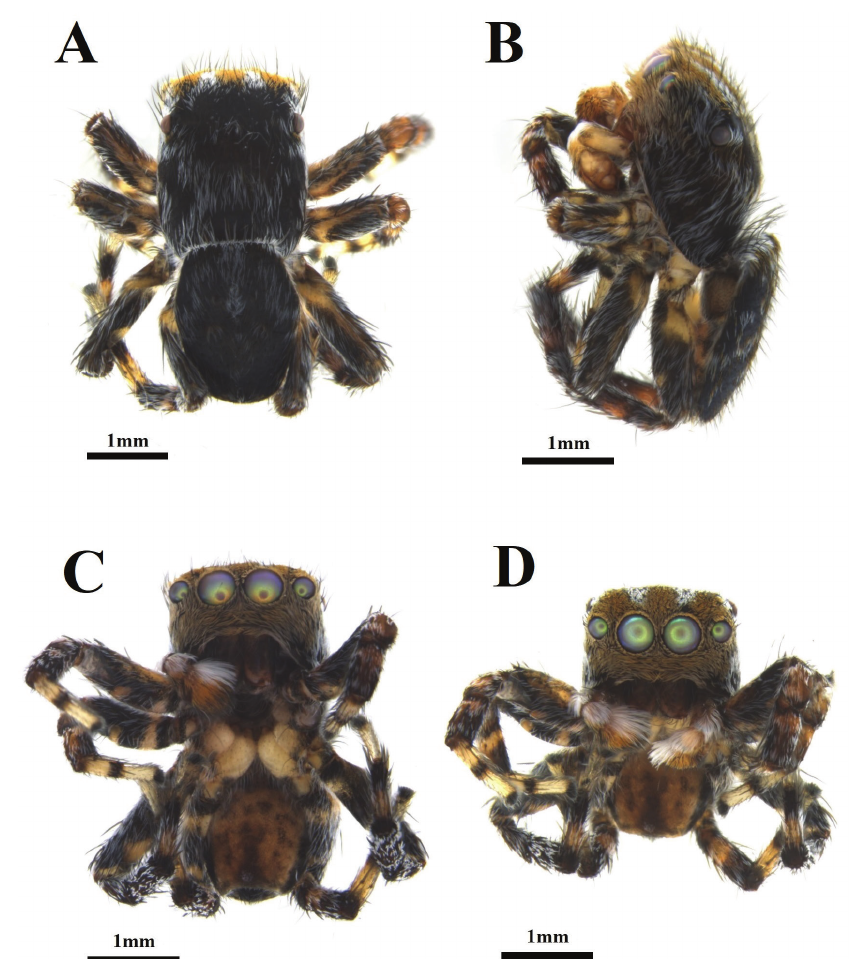
Figure 2. Preserved holotype Maratus nemo sp. nov. (SAM NN30706) A dorsal view B lateral view C ventral view D anterior view. Scale bars: 1mm).